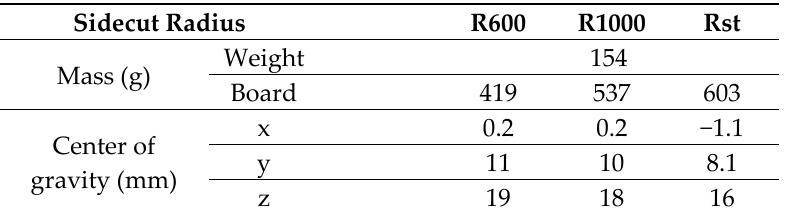
Table 1. Board parameters.